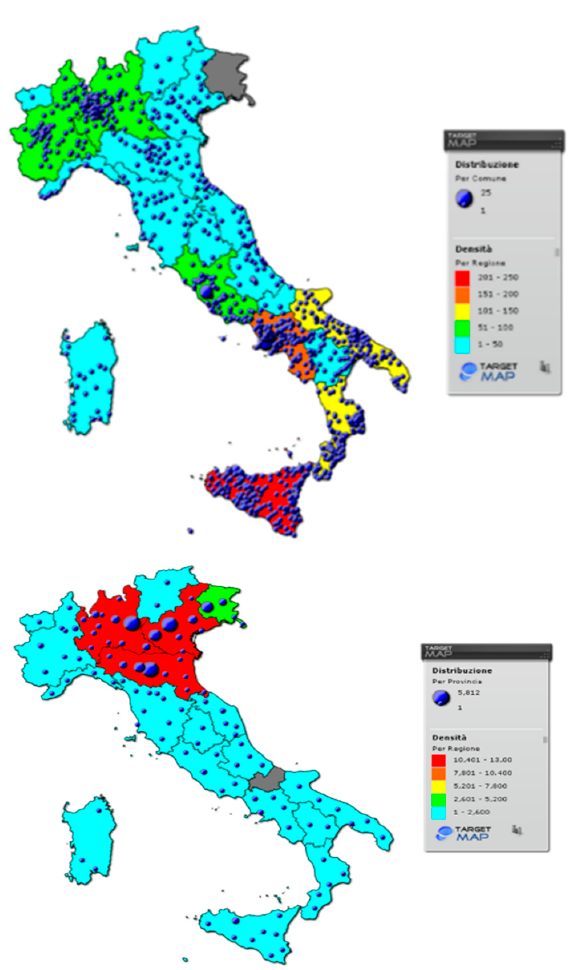
Figure 3. Neo-Pentecostal Churches from Nigeria and Ghana in Italy.